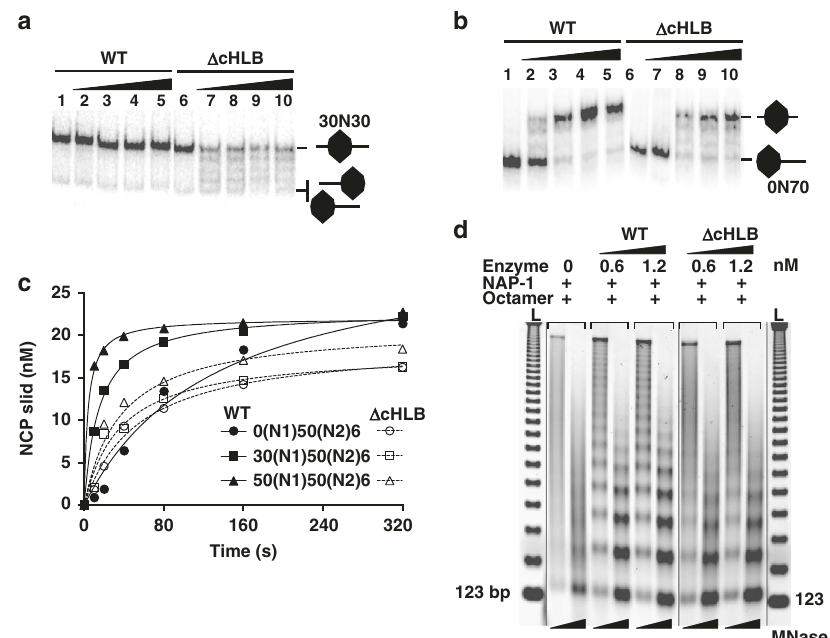
Fig. 6 Truncation of the HLB domain relaxes the linker DNA speci fi city of ISW1a with mononucleosomes and interferes with its nucleosome spacing and dinucleosome remodeling activities. a , b Gel shift image showing remodeling of ( a ) 30N30 and ( b ) 0N70 mononucleosomes by ISW1a and ISW1a Δ cHLB with reaction conditions similar to Fig. 2c. Remodeling assays were from three independent experiments. c Plot comparing the amount of dinucleosome remodeled by ISW1a and ISW1a Δ cHLB with varying fl anking DNA (0-, 30-, and 50-(N1)50(N2)6) over time similar to that shown in Fig. 2e. The estimated rate of dinucleosomes remodeled by ISW1a with 0, 30 and 50 bp of fl anking DNA were 0.23, 1.2, and 2.8 nM s − 1 respectively and the rate of dinucleosomes remodeled by ISW1a Δ cHLB with 0, 30, and 50 bp of fl anking DNA were 0.33, 0.46, and 0.53 nM s − 1 respectively. d The image of an agarose gel stained with Sypro Gold comparing the spacing activity of wild-type and Δ cHLB ISW1a in the presence of NAP-1 (Nucleosome assembly protein – 1). Source data are provided as a Source Data fi